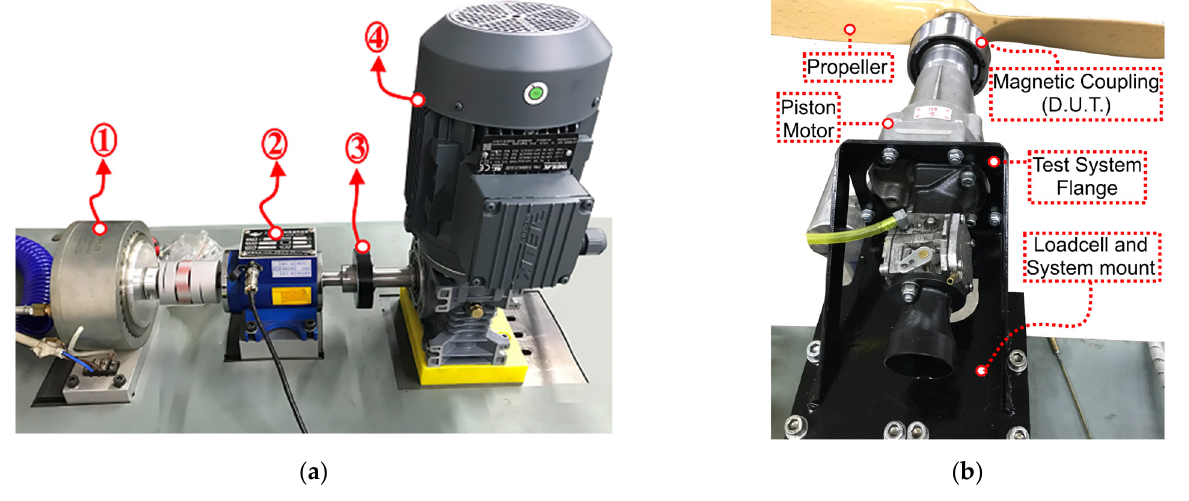
Figure 23. Test system of: ( a ) Direct dynamic method; ( b ) Thrust measurement method.